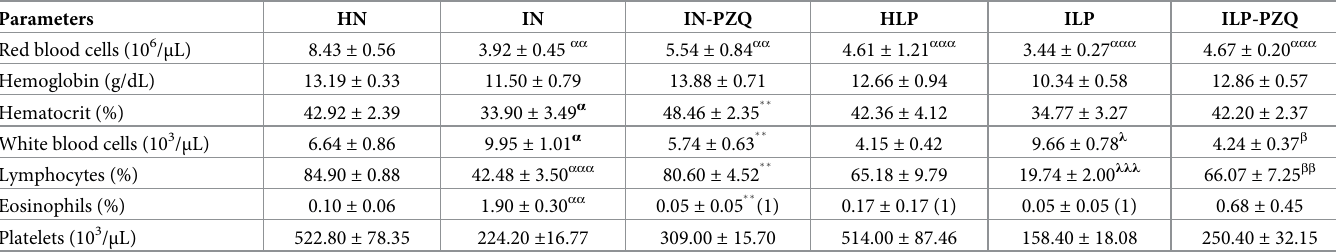
Table 4. Effects of praziquantel treatment on blood parameters in Schistosoma mansoni -infected mice receiving a low-protein diet. Parameters IN